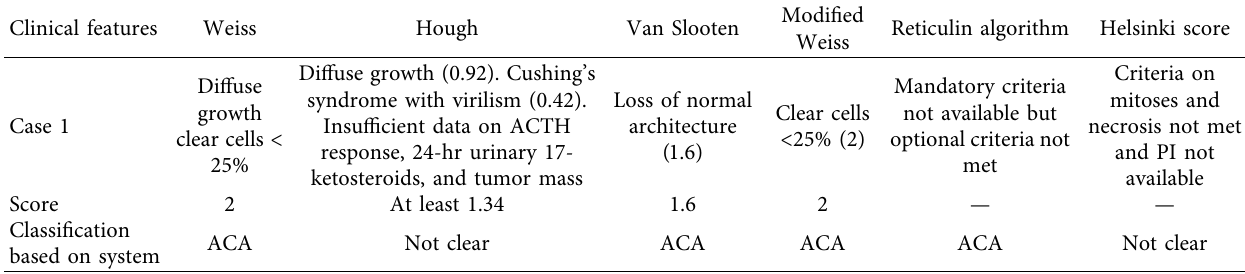
Table 4: Suggested pathological diagnosis of the adrenocortical tumor at the first operation of Patient A based on different classification systems on retrospective pathology review. The tumor would have been classified as ACA by the majority of systems. Clinical features